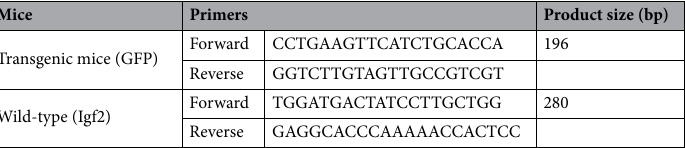
Table 1. Primer sequences used for mouse genotyping and transgene copy number determination.